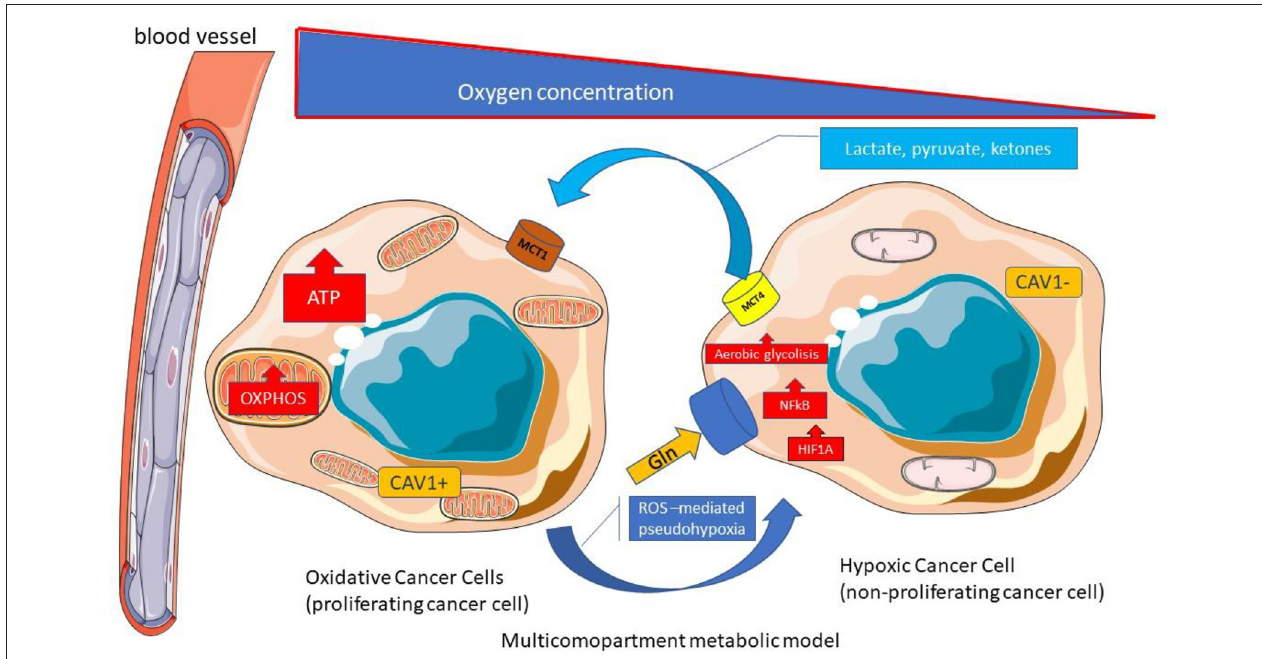
FIGURE 7 | Multicompartment metabolic model. Multicompartimental metabolism model is similar to the reverse Warburg effect. In the multicompartimental model, the cell compartment of cancer cells is divided into a very proliferative compartment (consisting of oxidative cancerous cells with MCT1 expression) and a less proliferative compartment (consisting of hypoxic cancer cells). ATP, Adenosine triphosphate; CAV, Caveolin; Gln, Glutamine; HIF1A, Hypoxia-inducible factor 1-alpha; MCT, Monocarboxylated transporter; NF- κ B, Nuclear factor kappa B; OXPHOS, Oxidative phosphorylation; TCA Tricarboxylic acid; ROS; Reactive Oxygen